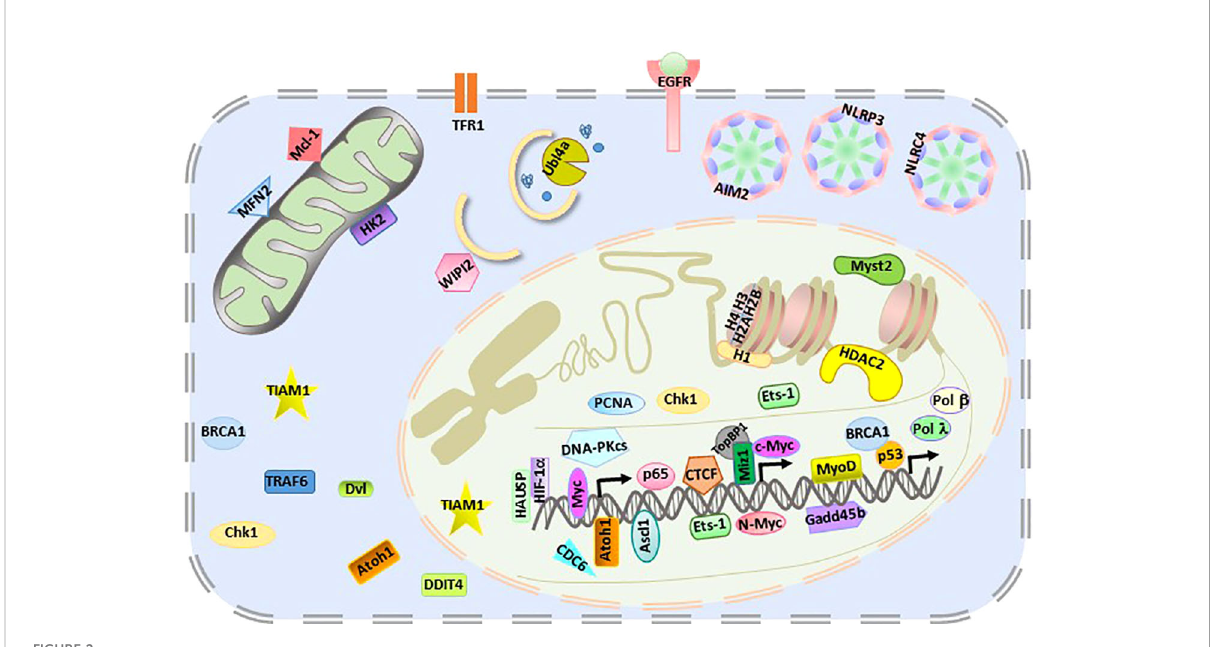
FIGURE 2 Intracellular localization of HUWE1